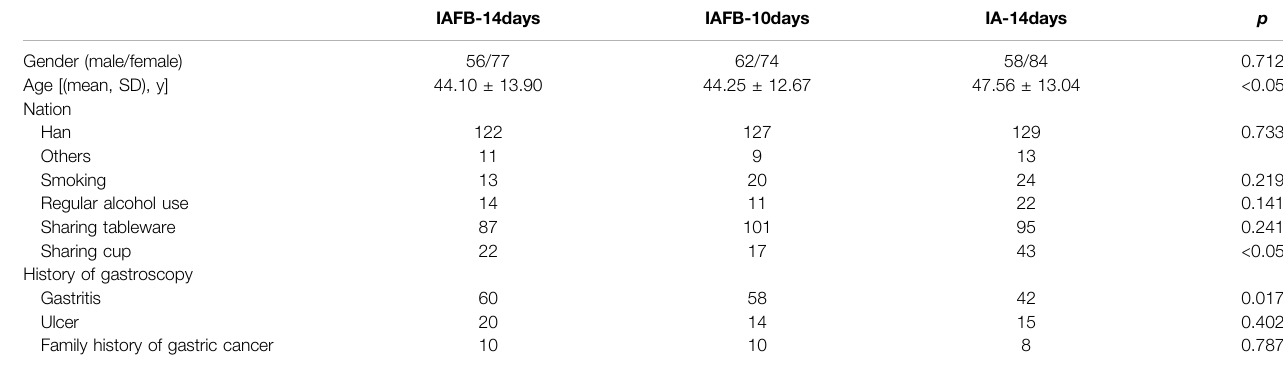
TABLE 1 | Demographic and clinical data of